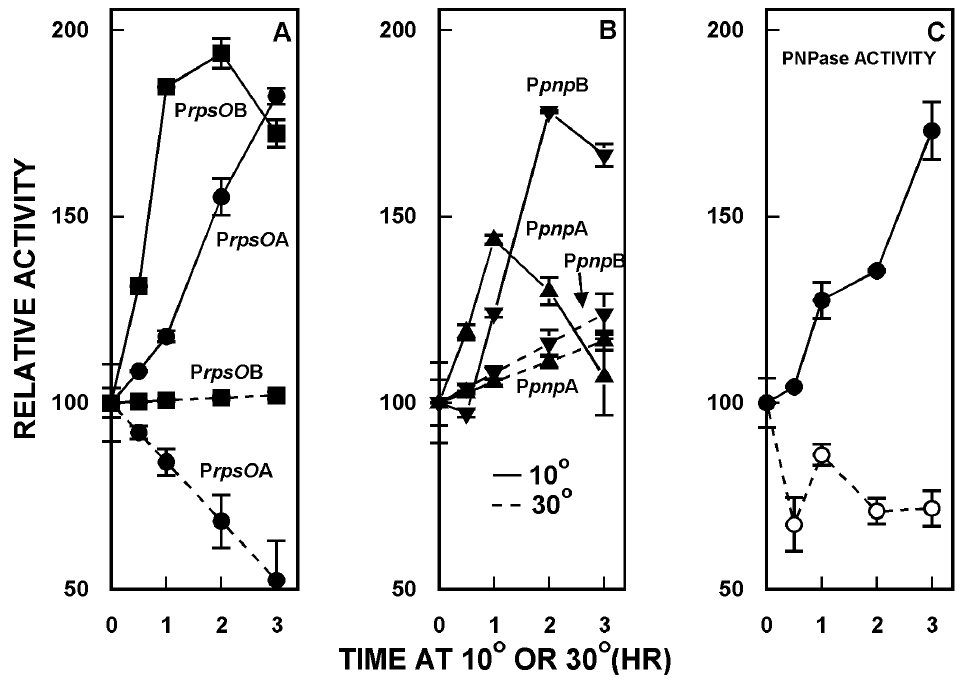
Figure 3. Cold shock responses of S. coelicolor . Derivatives containing the rpsO–pnp promoter probe constructs were grown and 30 °C, and half of each culture was then shifted to 10 °C. Mycelium was harvested at the indicated times, disrupted by sonication, and following centrifugation, supernatants were assayed for promoter activity, as described [31,35]. Panel C shows the results of PNPase polymerization assays. In Panels A and B, PNPase promoter activities are expressed relative to the activity measured at 30 °C at zero time, immediately before the shift to 10 °C. The results shown are the averages of duplicate assays from two independent experiments ± SEM. In the first experiment, PNPase levels were measured in S. coelicolor containing P rpsO A and in the second, PNPase levels were measured in the derivative containing P pnp B. This figure is reprinted from Gene, 536, Patricia